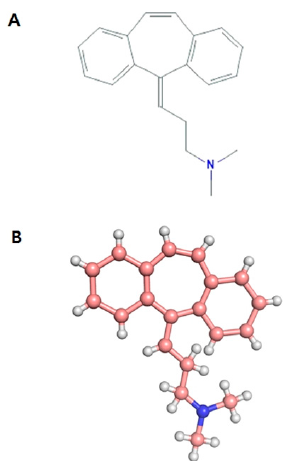
Figure 1. Structural representations of cyclobenzaprine: ( A ) 2-D structure and ( B ) 3-D structure.